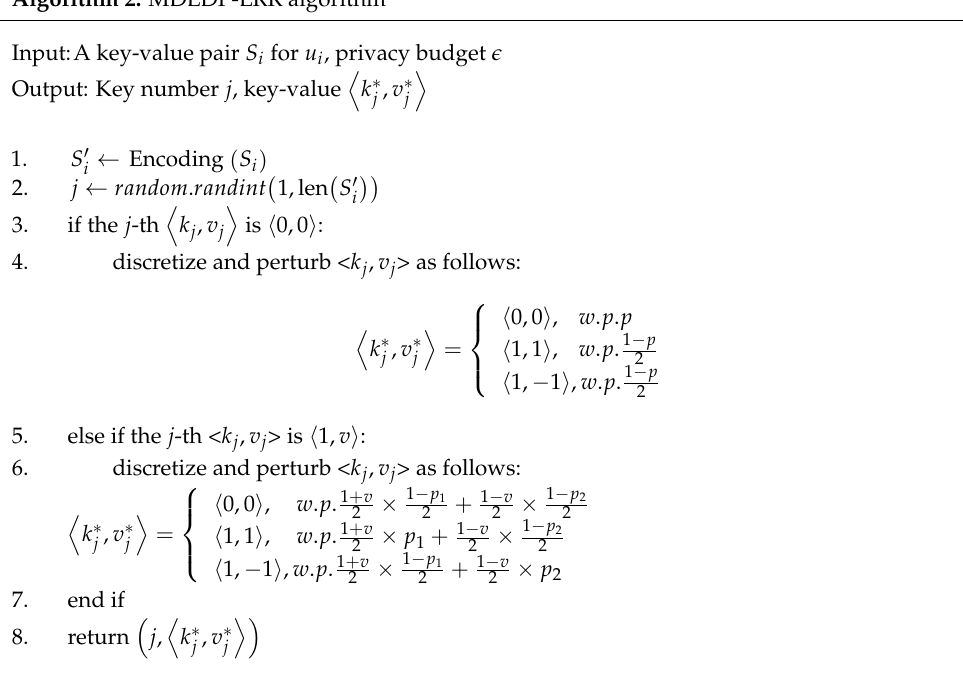
Algorithm 2: MDLDP-LRR